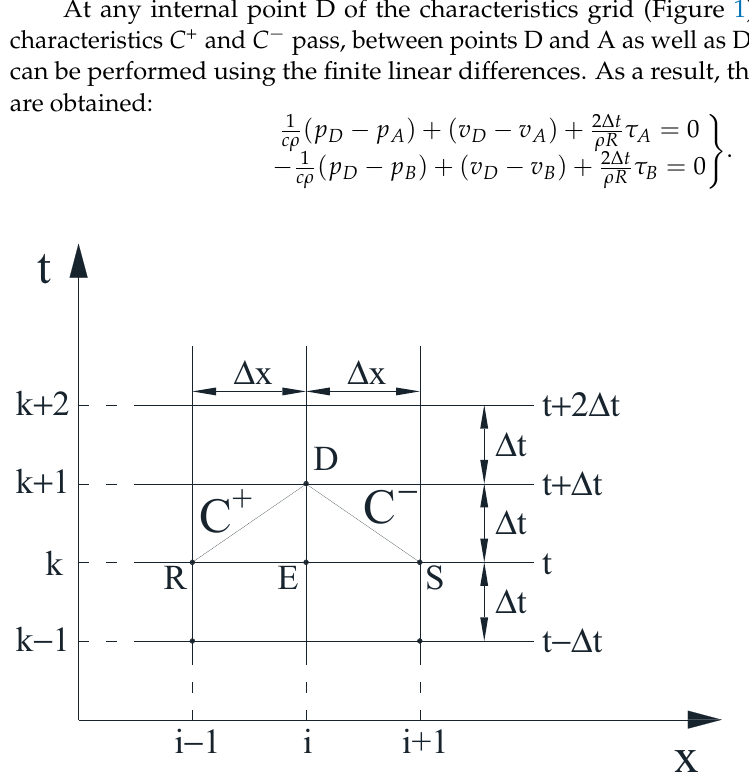
Figure 1. Method of characteristics grid.